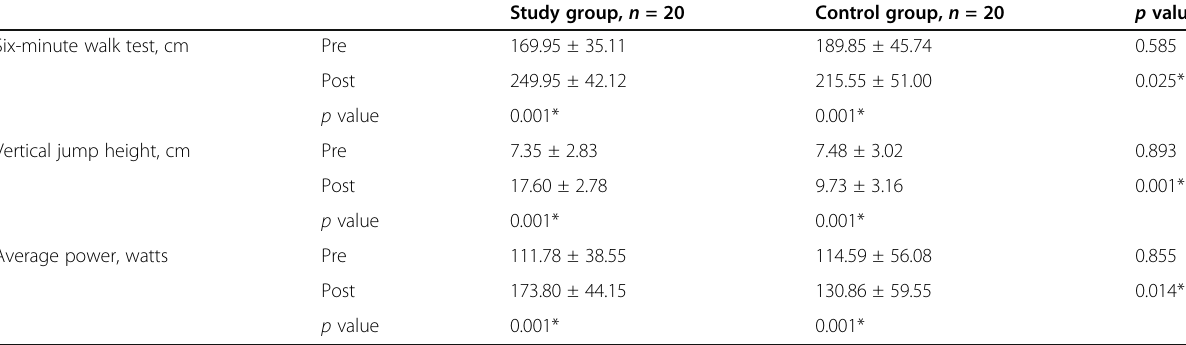
Table 3 The values of 6 MWT, VJH, and power before and after the intervention